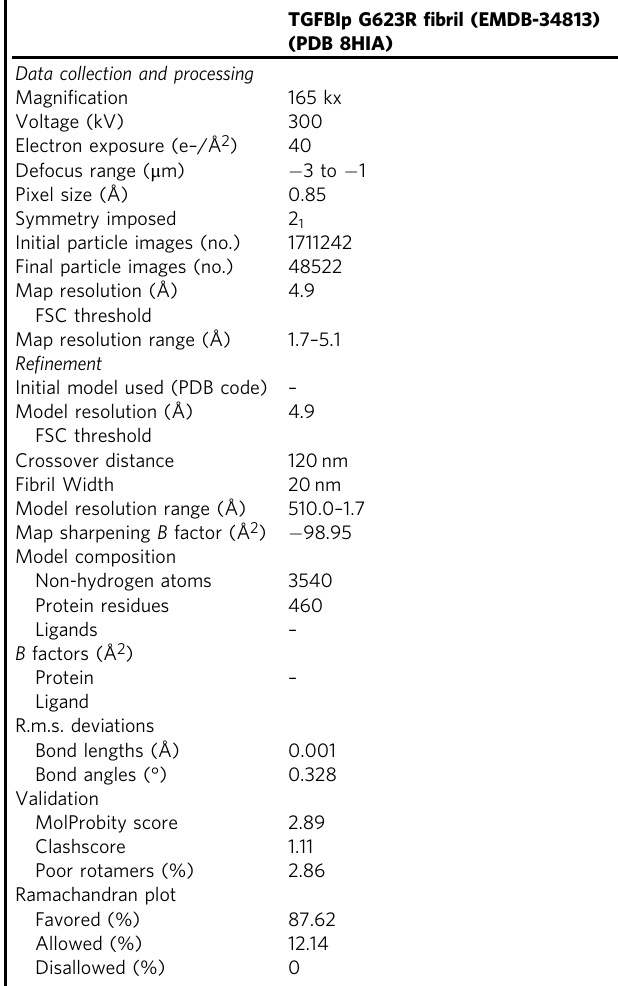
Table 2 Cryo-EM data collection, re fi nement and validation statistics.